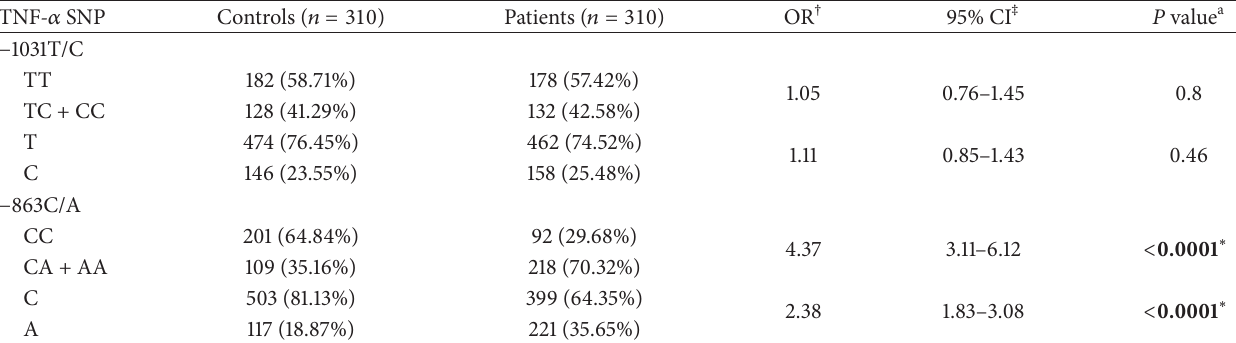
Table 2: Genotype and allele frequencies of the TNF- 𝛼 gene − 1031T > C and − 863C > A polymorphisms in the study